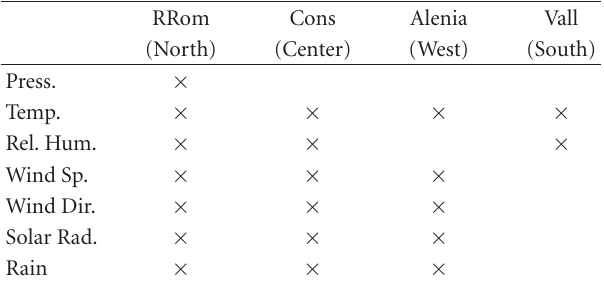
Table 2: Available meteorological